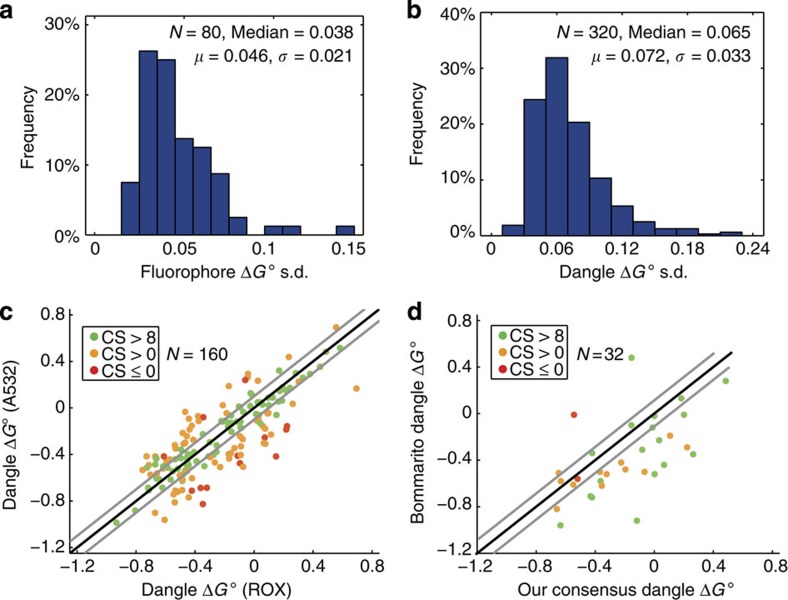
Error analysis of native characterization methodology.(a) Distribution of mean s.d.'s of a fluorophore next to a duplex (Fig. 2). All 80 fluorophore ΔG° parameters we obtained have mean s.d. below 0.15 kcal mol−1. (b) Distribution of mean s.d.'s of single-nucleotide dangles (Fig. 3). All 320 single-base dangle parameters have mean s.d. below 0.25 kcal mol−1. Because dangle ΔG° values were obtained by subtracting two ΔG° values each with their own independent s.d.'s, the s.d.'s are larger than those in a. (c) Comparison of dangle ΔG° values obtained via ROX and via Alexa532. Black line shows equality and grey lines show ±0.1 kcal mol−1 deviation. Of the 160 parameter pairs, 80 (50.0%) have CS >8, 66 (41.25%) have CS between 0 and 8, and 14 (8.75%) have CS <0. (d) Comparison of our consensus dangle ΔG° values with literature values by Bommarito et al.
59